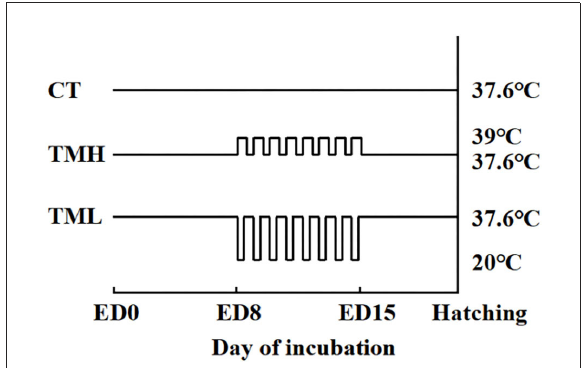
FIGURE1 Incubation treatments. CT, control incubation temperature until hatching at 37.6 ◦ C; TMH, thermal manipulation with high temperature (39 ◦ C, 8 h/day) from embryonic day (ED) 8 to ED 15; TML, thermal manipulation with low temperature (20 ◦ C, 1 h/day) from ED 8 to 15. All eggs were transferred to the hatcher at ED